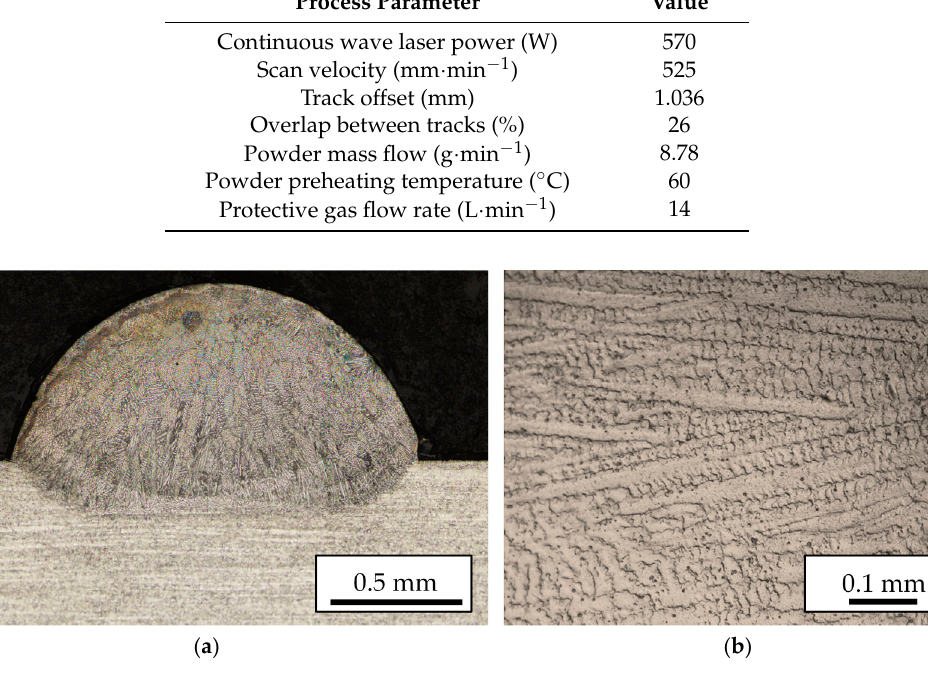
Figure 1. ( a ) Cross section of a single clad; ( b ) Detail of the microstructure.